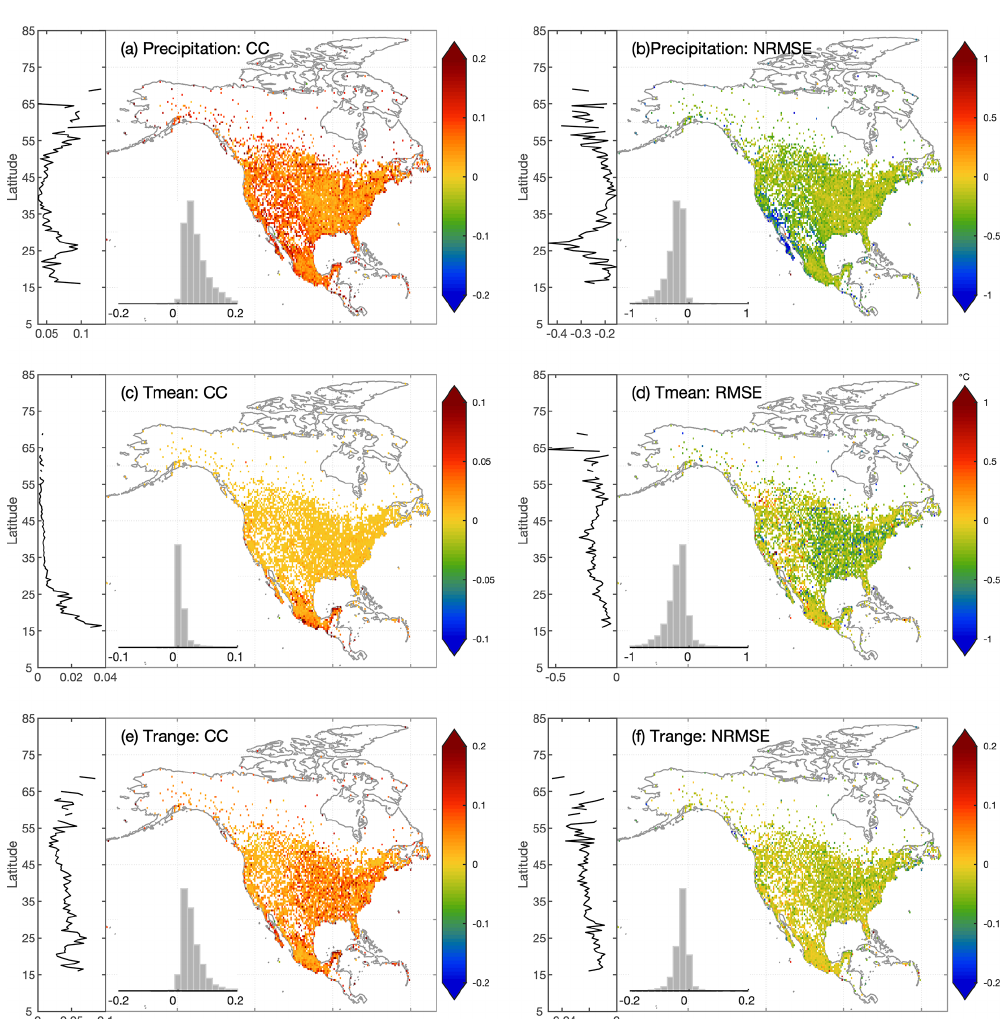
Figure 7. Similar with Fig. 6, but the differences are between OI-merged precipitation estimates and station-based regression precipitation